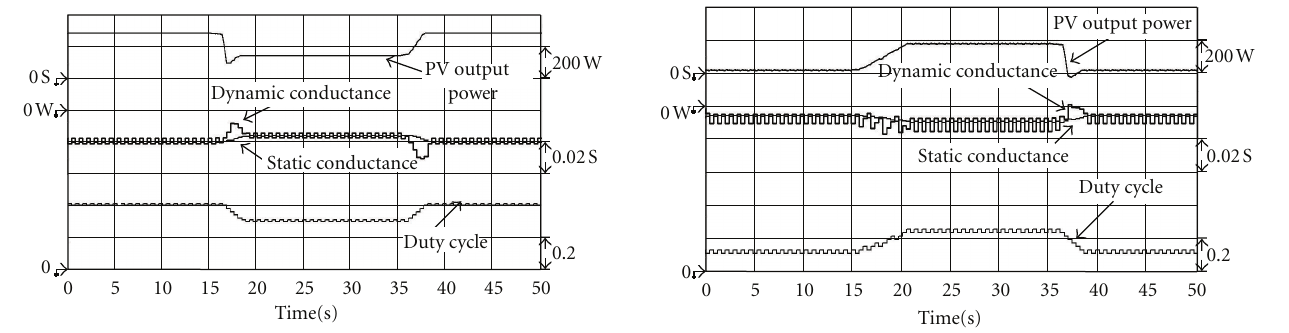
Figure 10: Simulated output power, dynamic conductance, static conductance, and duty cycle waveforms of a PV module array using the variable step size INC method under irradiation that dropped from 1,000 W/m 2 to 700W/m 2 and then increased back up to 1,000 W/m 2 .